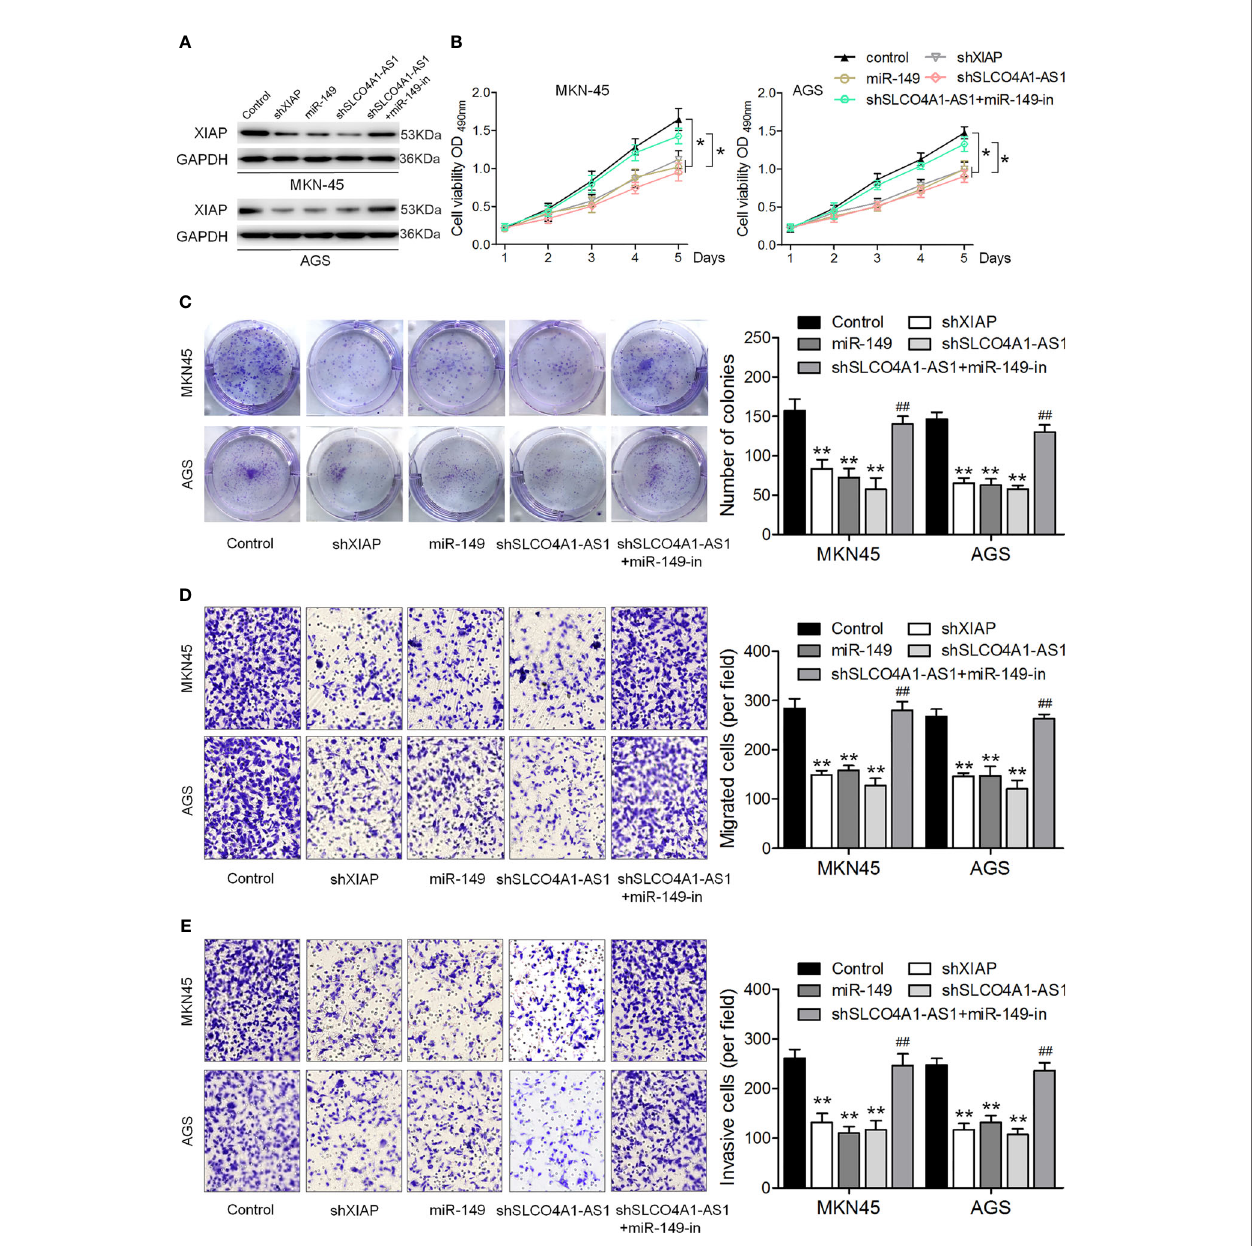
FIGURE 4 | SLCO4A1-AS1 knockdown inhibits the migratory and invasive abilities of GC cells by promoting miR-149 expression. (A) Western blotting assay for determining XIAP protein expression in XIAP shRNA, miR-149 mimic, SLCO4A1-AS1 shRNA, and SLCO4A1-AS1 shRNA plus miR-149 inhibitor transfected GC cells. (B) Cell proliferation was determined using CCK-8 assay. (C) Cell cloning capability was measured using colony formation assay. (D) Cell migratory ability was detected using Transwell migration assay. (E) Cell invasive ability was determined using Transwell invasion assay. * P < 0.05, ** P < 0.01 vs. control group. ## P < 0.01 vs. shSLCO4A1-AS1